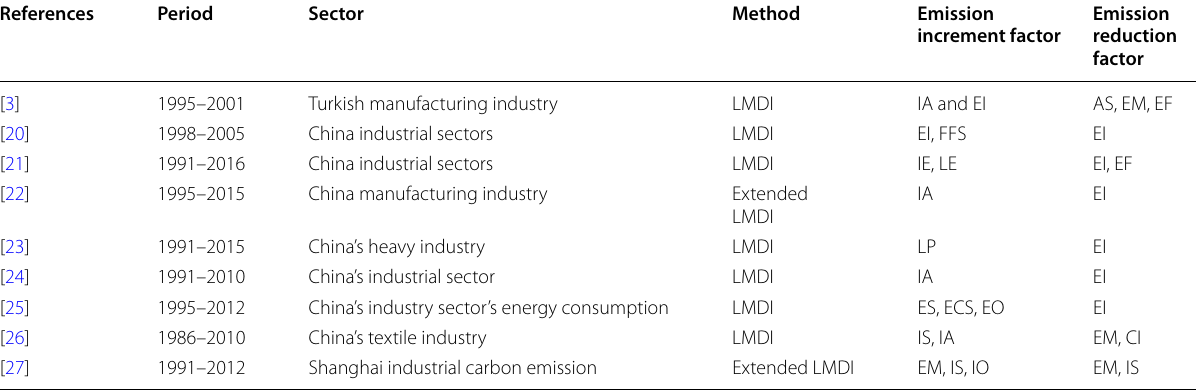
Table 1 Overview of previous emission-related decomposition studies in the manufacturing